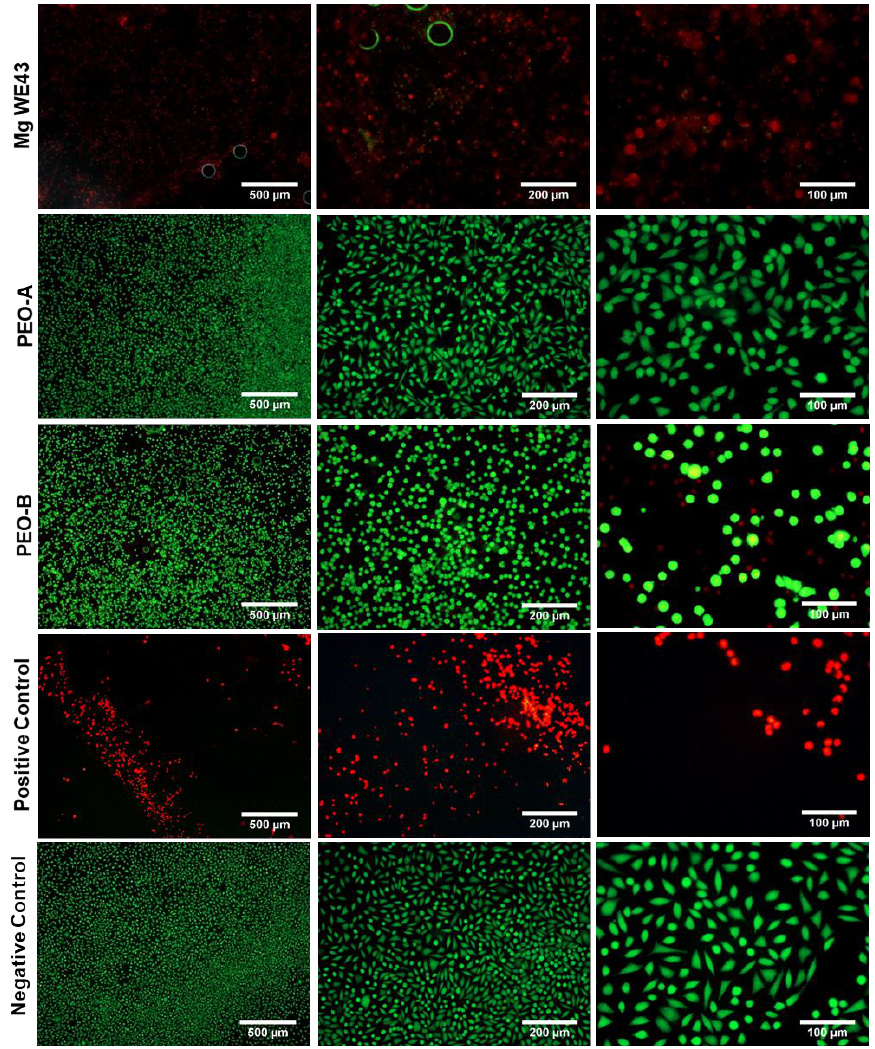
Figure 6. Live / dead staining of L-929-fibroblasts on the surfaces of Mg WE43, PEO-B and PEO-A. Green- and red-stained cells denote viable and non-viable cells, respectively. Cells populating PEO-B specimens showed the highest percentage of viable (green) cells, while those cultured on the Mg WE43 specimens exhibited the lowest viability.